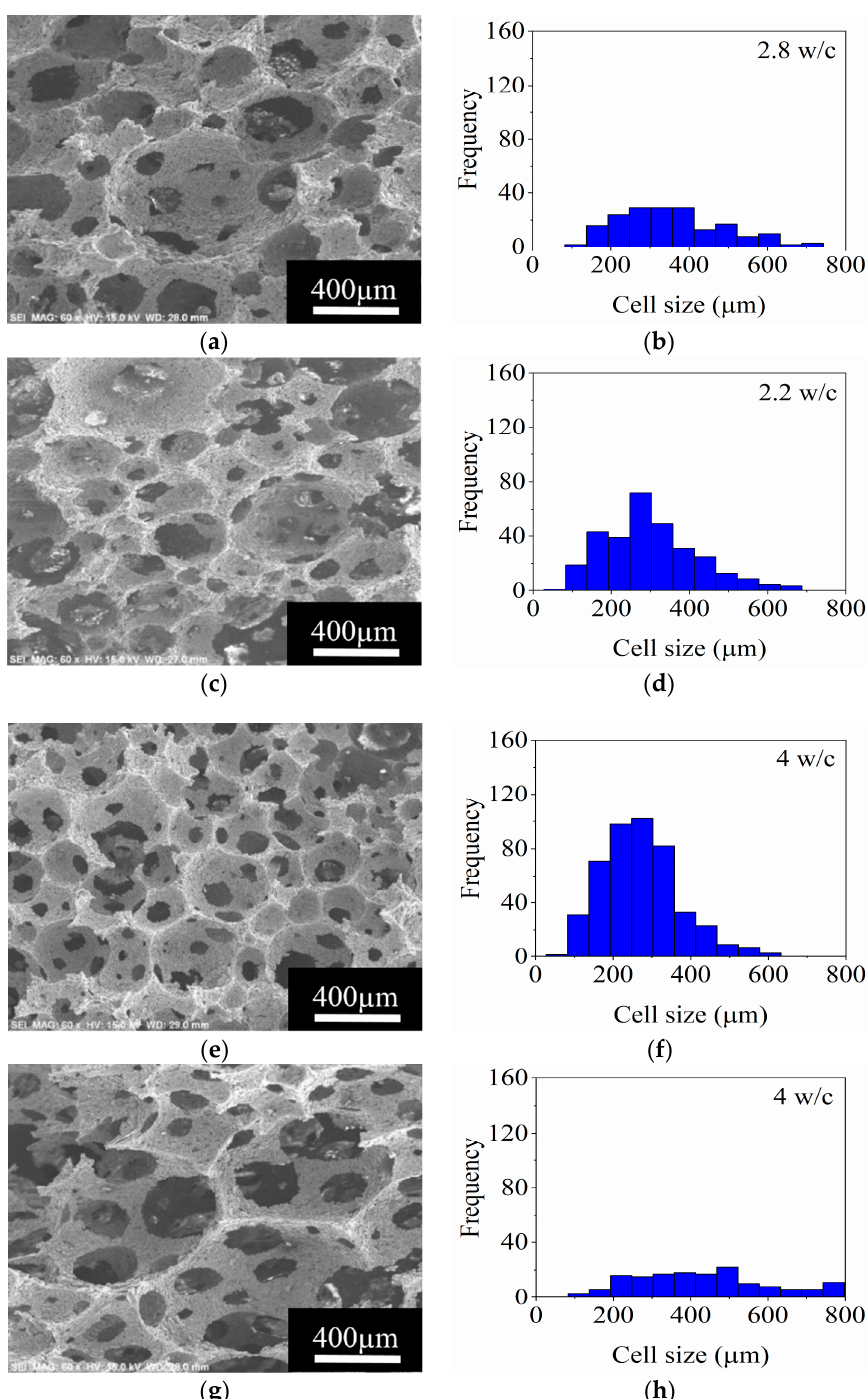
Figure 10. SEM micrographs and frequency histograms of the cell size obtained using the 4-arm anchor impeller at different stirring rates: ( a ) and ( b ), 1070 rpm; ( c ) and ( d ), 1194 rpm; ( e ) and ( f ), 1240 rpm; and ( g ) and ( h ), 1283 rpm, respectively.